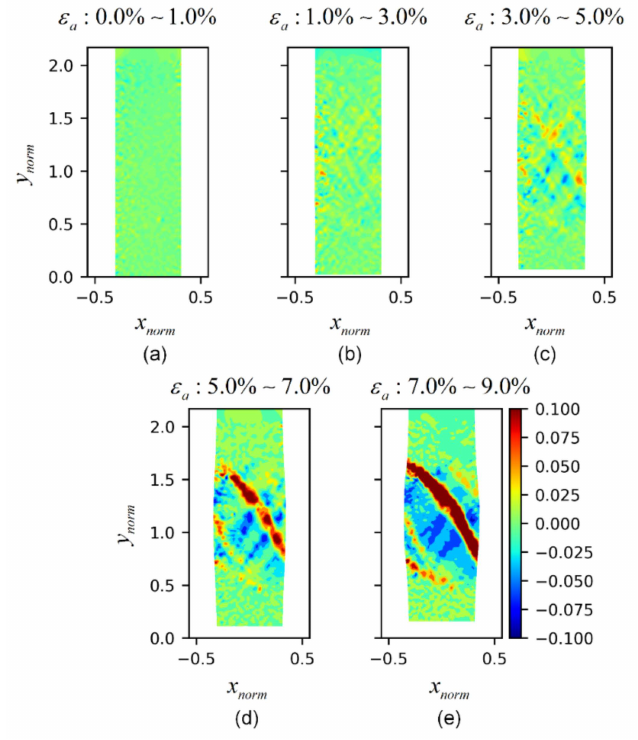
Figure 10. Evolution of curl along ˆ ρ axis ( curl U ) of test 092903b: ( a ) axial strain 0.0%–1.0%; ( b ) axial ρ strain 1.0%–3.0%; ( c ) axial strain 3.0%–5.0%; ( d ) axial strain 5.0%–7.0%; ( e ) axial strain 7.0%–9.0%.